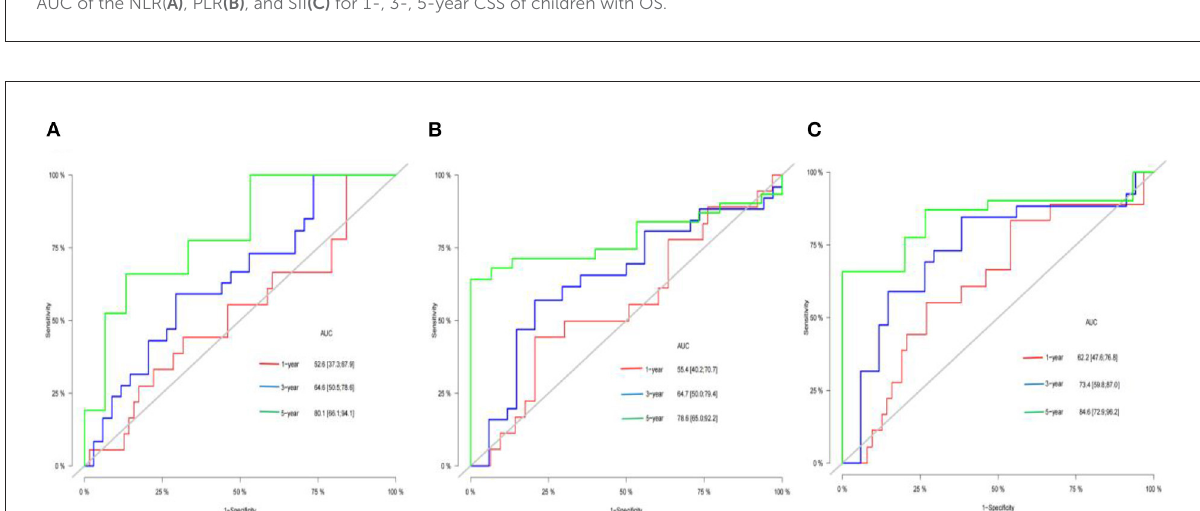
FIGURE2 AUC of the NLR (A) , PLR (B) , and SII (C) for 1-, 3-, 5-year EFS of children with